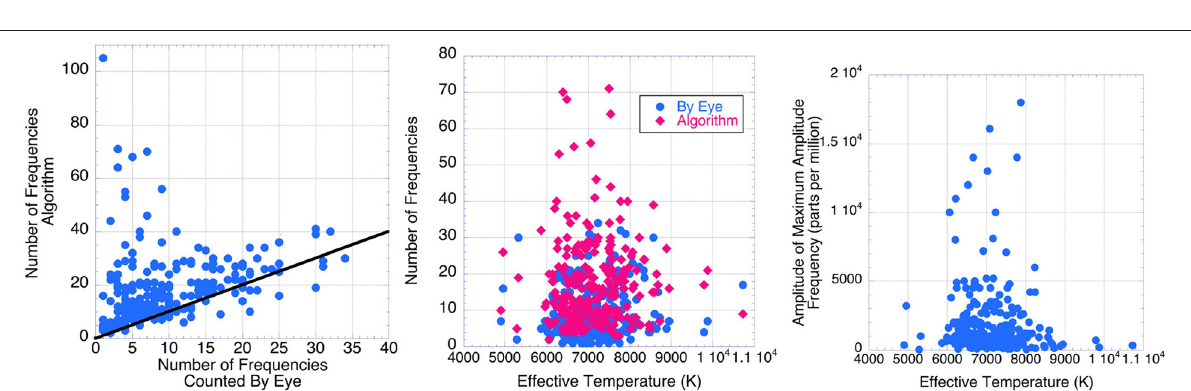
FIGURE 12 | Distributions of number of frequencies per star > 5 c/d (Left) , amplitude of maximum-amplitude mode (Center) , and frequency of maximum-amplitude mode (Right) for 249 δ Sct candidates.